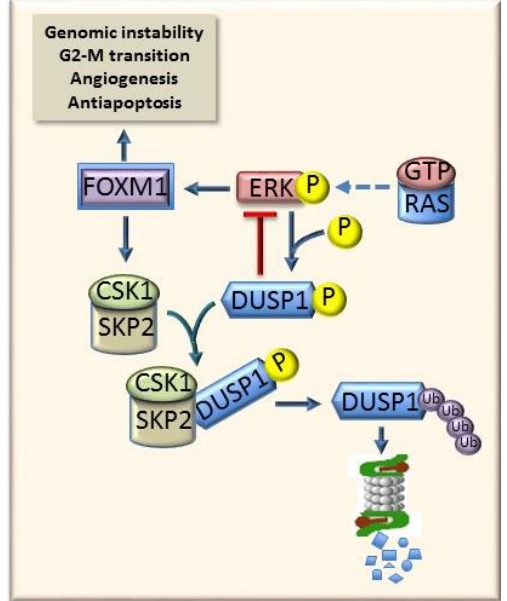
Figure 5. Crosstalk between RAS-ERK pathway and FOXM1. The ERK1/2 inhibitor DUSP1 may restrain the activity of RAS (RAS-GTP) and ERK1/2 signaling. The activation of FOXM1, an ERK1/2 target, and that of DUSP1, by phosphorylation of Ser296 residue allows the DUSP1 ubiquitination and proteasomal degradation. Active FOXM1 strongly influences genomic instability, cell G2-M progression, cell survival, and angiogenesis.